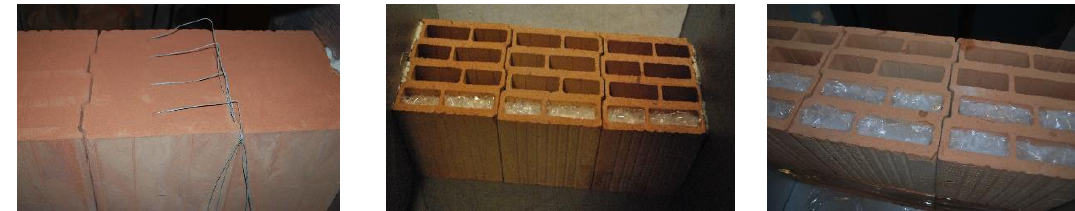
Figure 1. Modified ceramic airbricks without and with one row and two rows of gaps with phase change material.